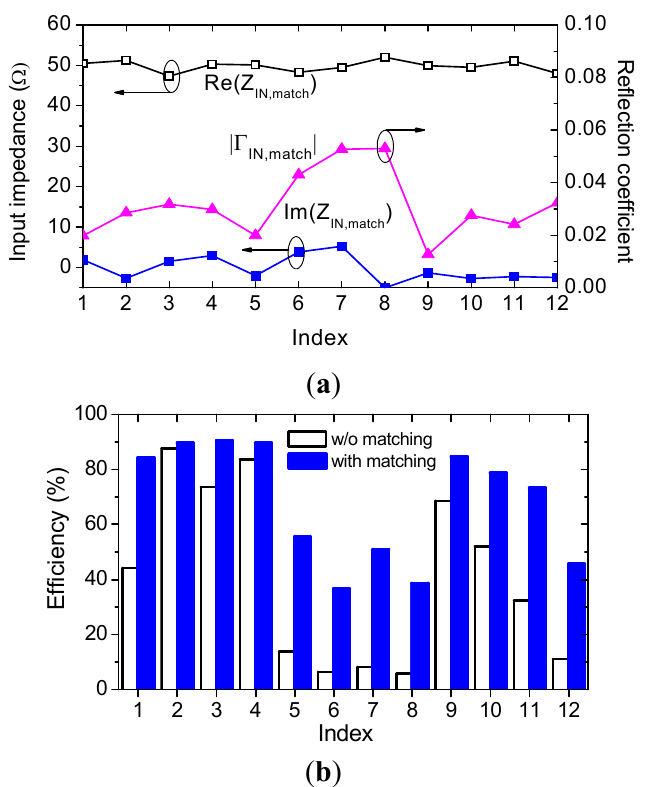
Figure 21. Measured results along the trajectory index: ( a ) input impedance and ( b )